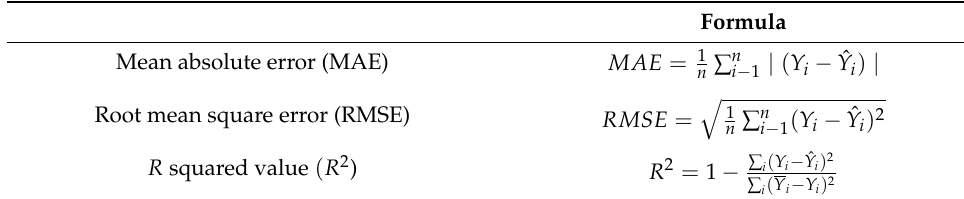
Table 5. Forecasting algorithm performance indexes.